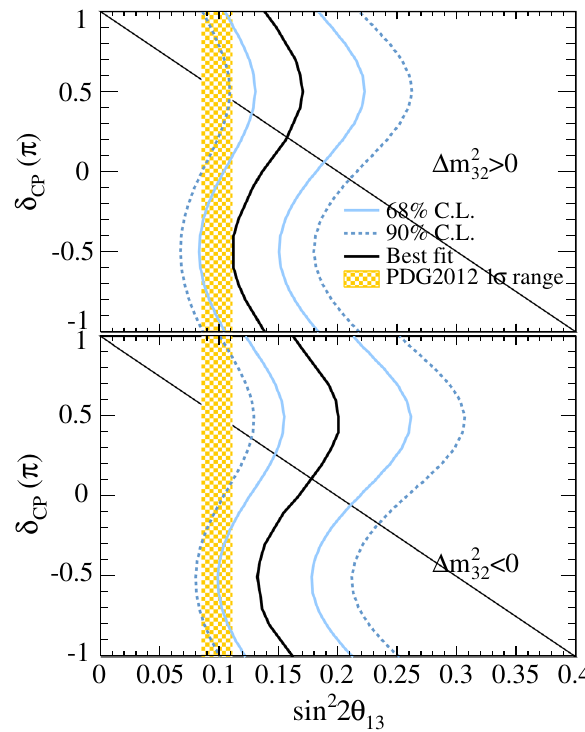
Fig. 58 The allowed regions for sin 2 2 θ 13 as a function of δ CP in the normal (top) and inverted (bottom) mass hierarchy case from [58]. The value of θ 13 from reactor experiments in PDG2012 is shown as the shaded region